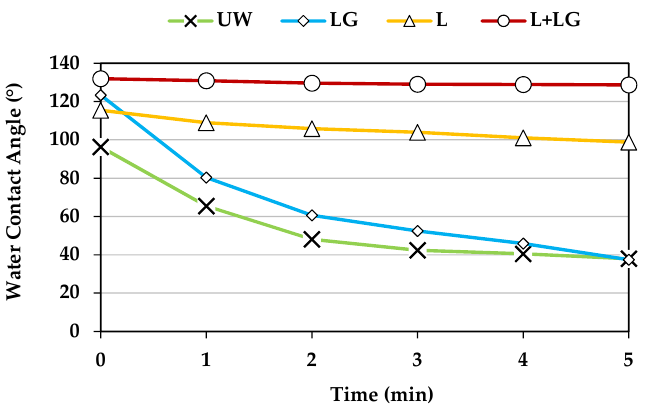
Figure 2. Water contact angle of beech wood veneers. Untreated (UW); treated with lauryl gallate (LG); laccase (L); and laccase and lauryl gallate (L + LG).